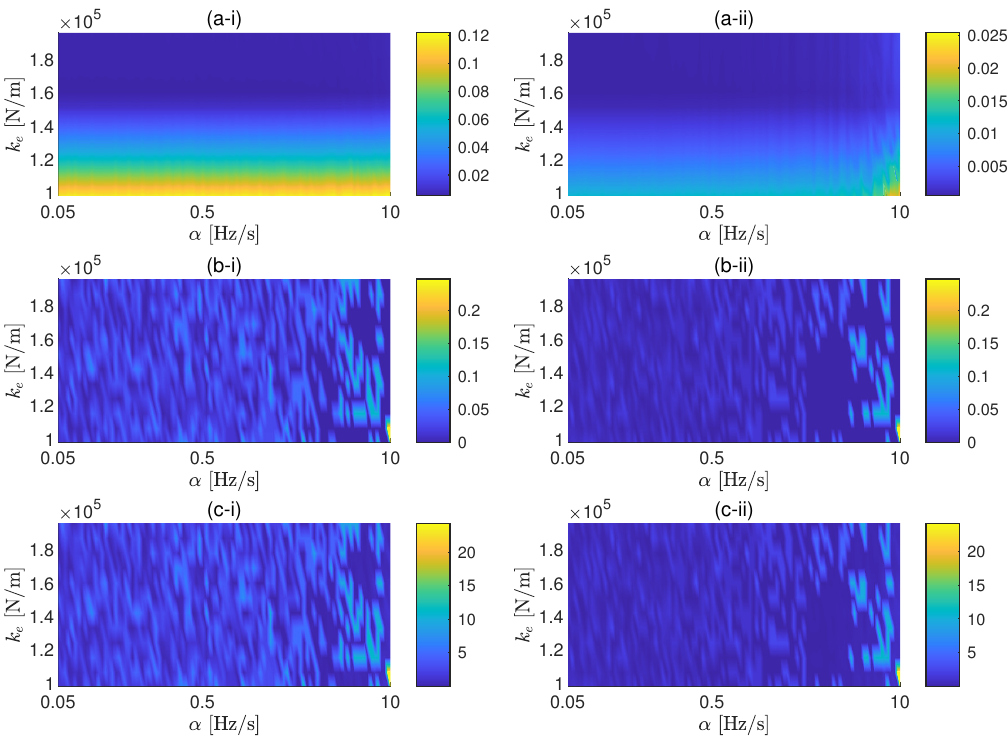
Figure 7. General ( a ), resonance frequency ( b ) and resonance amplitude ( c ) errors as a function of the sweep rates and the dynamic stiffness of the spring for excitation force amplitudes of 2.5 N (i) and 25 N (ii). Background noise: 3.3 × 10 − 10 m/s 2 .